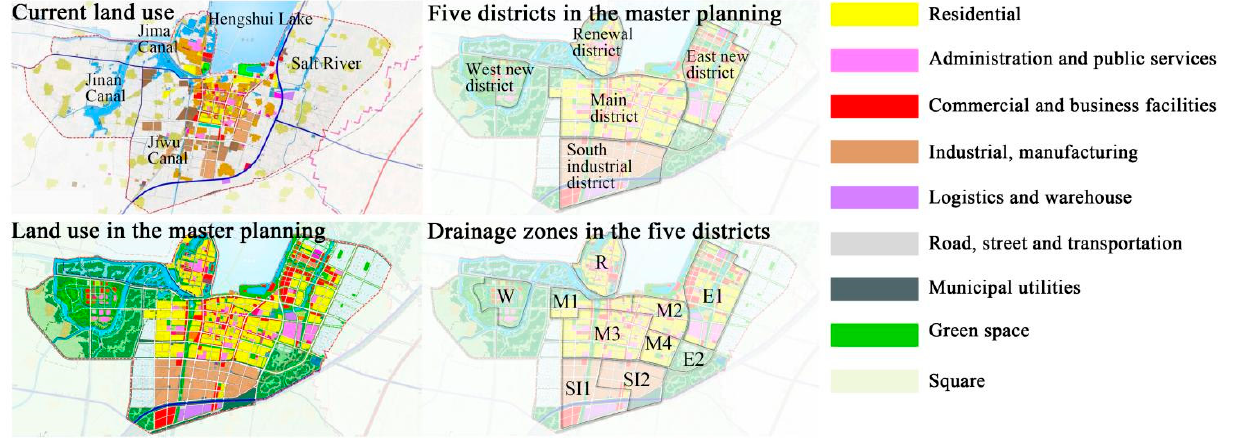
Figure 5. Land use and districts in current city and in the master planning of Jizhou 2015-2030.